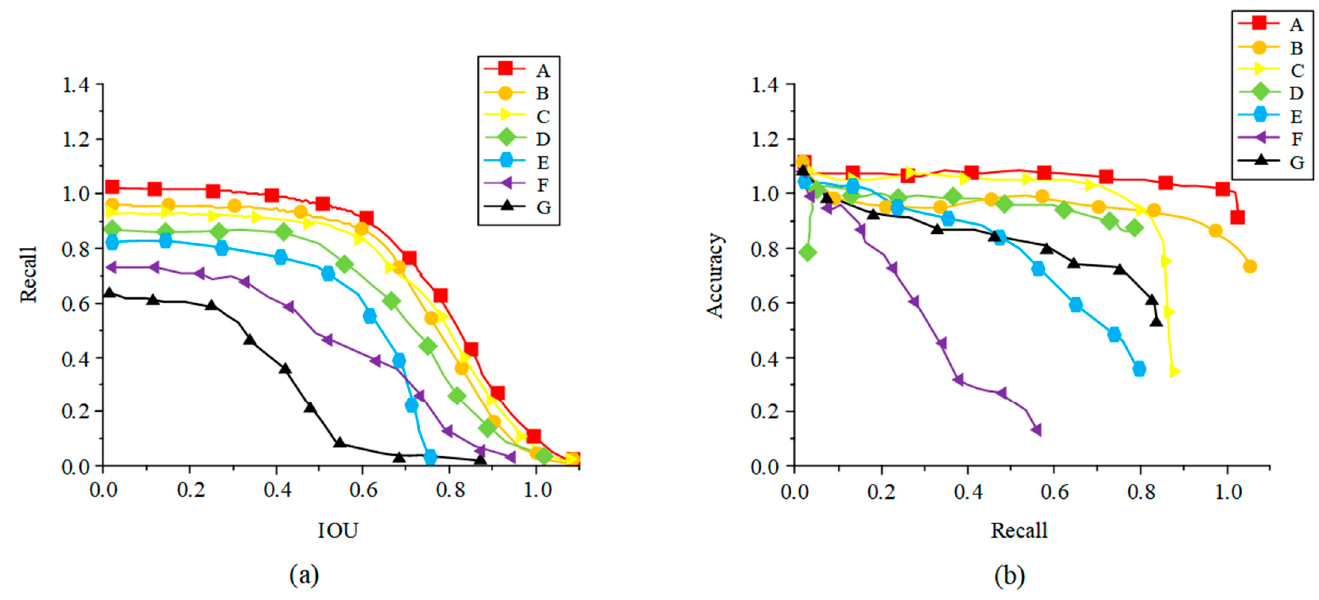
Figure 5. Performance comparison of different algorithms in the training phase. ( a ) is the IOU–recall curve and ( b ) is the recall–accuracy